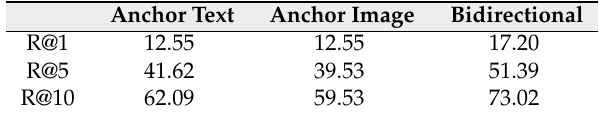
Table 7. Comparison between unidirectional and bidirectional